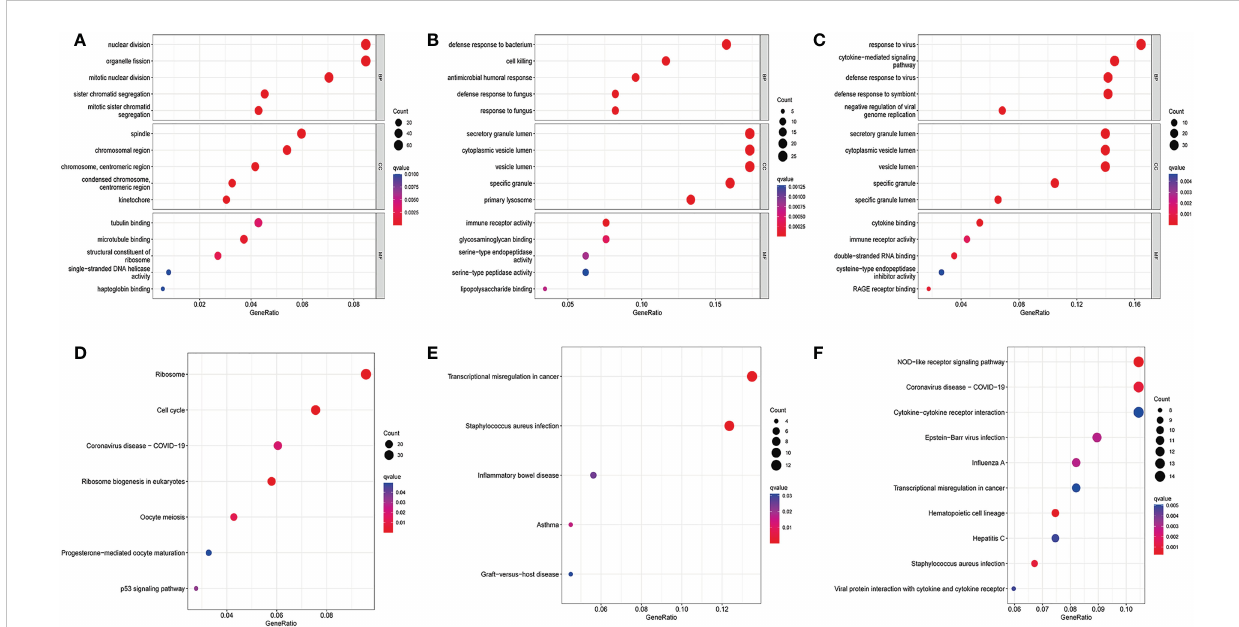
FIGURE 2 GO enrichment analysis and KEGG enrichment analysis. (A) Bubble for GO enrichment analysis of differentially expressed genes in the GSE157103 dataset, (B) Bubble for GO enrichment analysis of differentially expressed genes in the GSE111368 dataset, (C) Bubble for GO enrichment analysis of differentially expressed genes in the GSE101702 dataset, (D) Bubble for KEGG enrichment analysis of differentially expressed genes in the GSE157103 dataset, (E) Bubble for KEGG enrichment analysis of differentially expressed genes in the GSE111368 dataset, (F) Bubble for KEGG enrichment analysis of differentially expressed genes in the GSE101702 dataset.